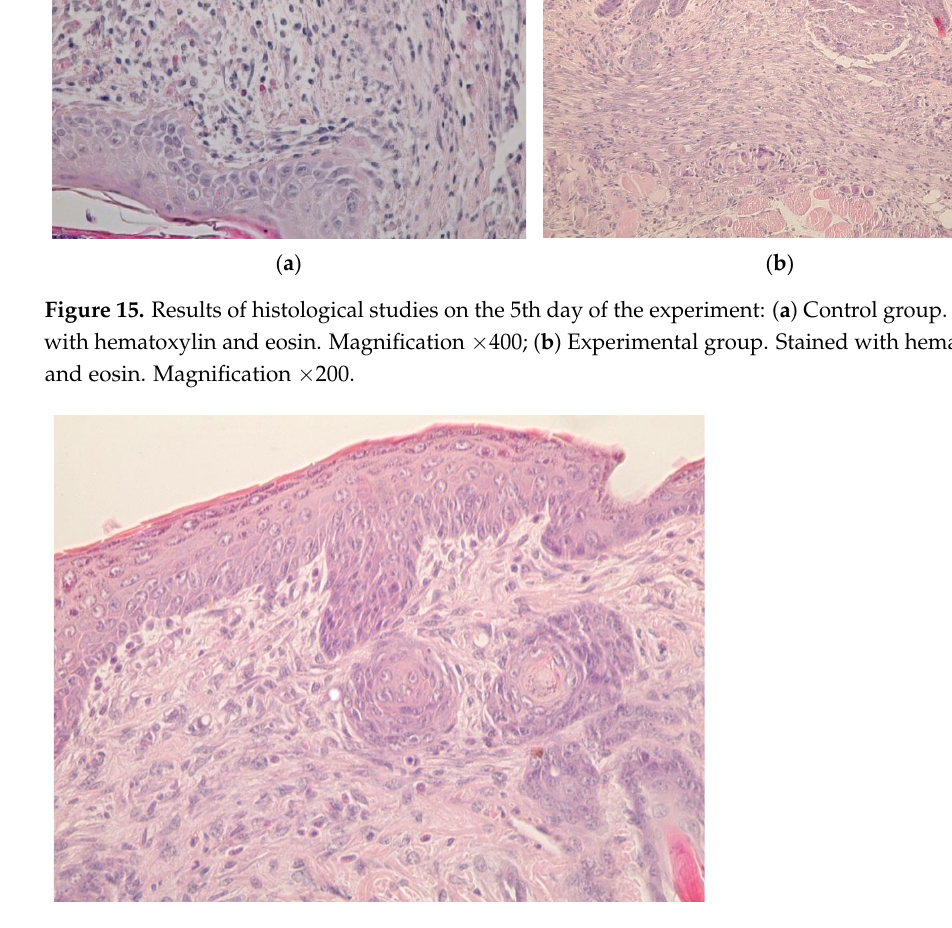
Figure 15. Results of histological studies on the 5th day of the experiment: ( a ) Control group . Stained with hematoxylin and eosin. Magnification ×400; ( b ) Experimental group . Stained with hematoxylin and eosin. Magnification ×200.